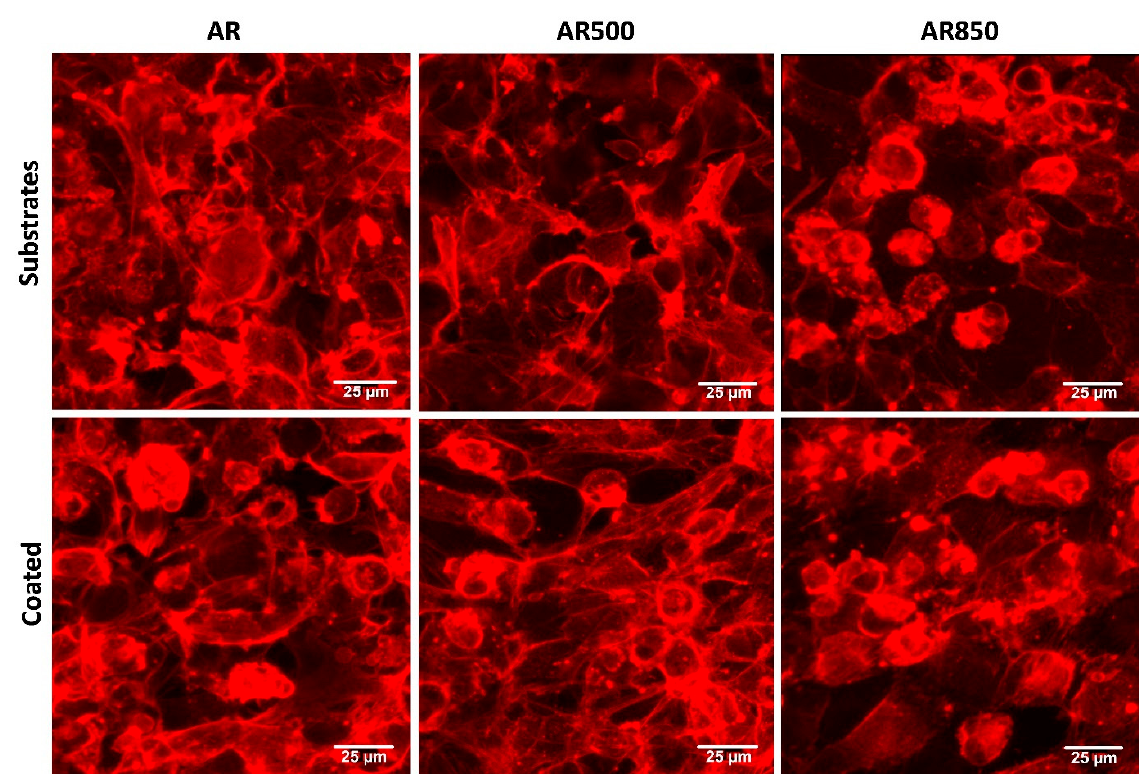
Figure 12. Representative fluorescent images showing cell morphology of MG63 cultured on bare and coated substrates for 24 h. The cytoskeleton was visualized by F-actin staining. Bars 25 μ m.